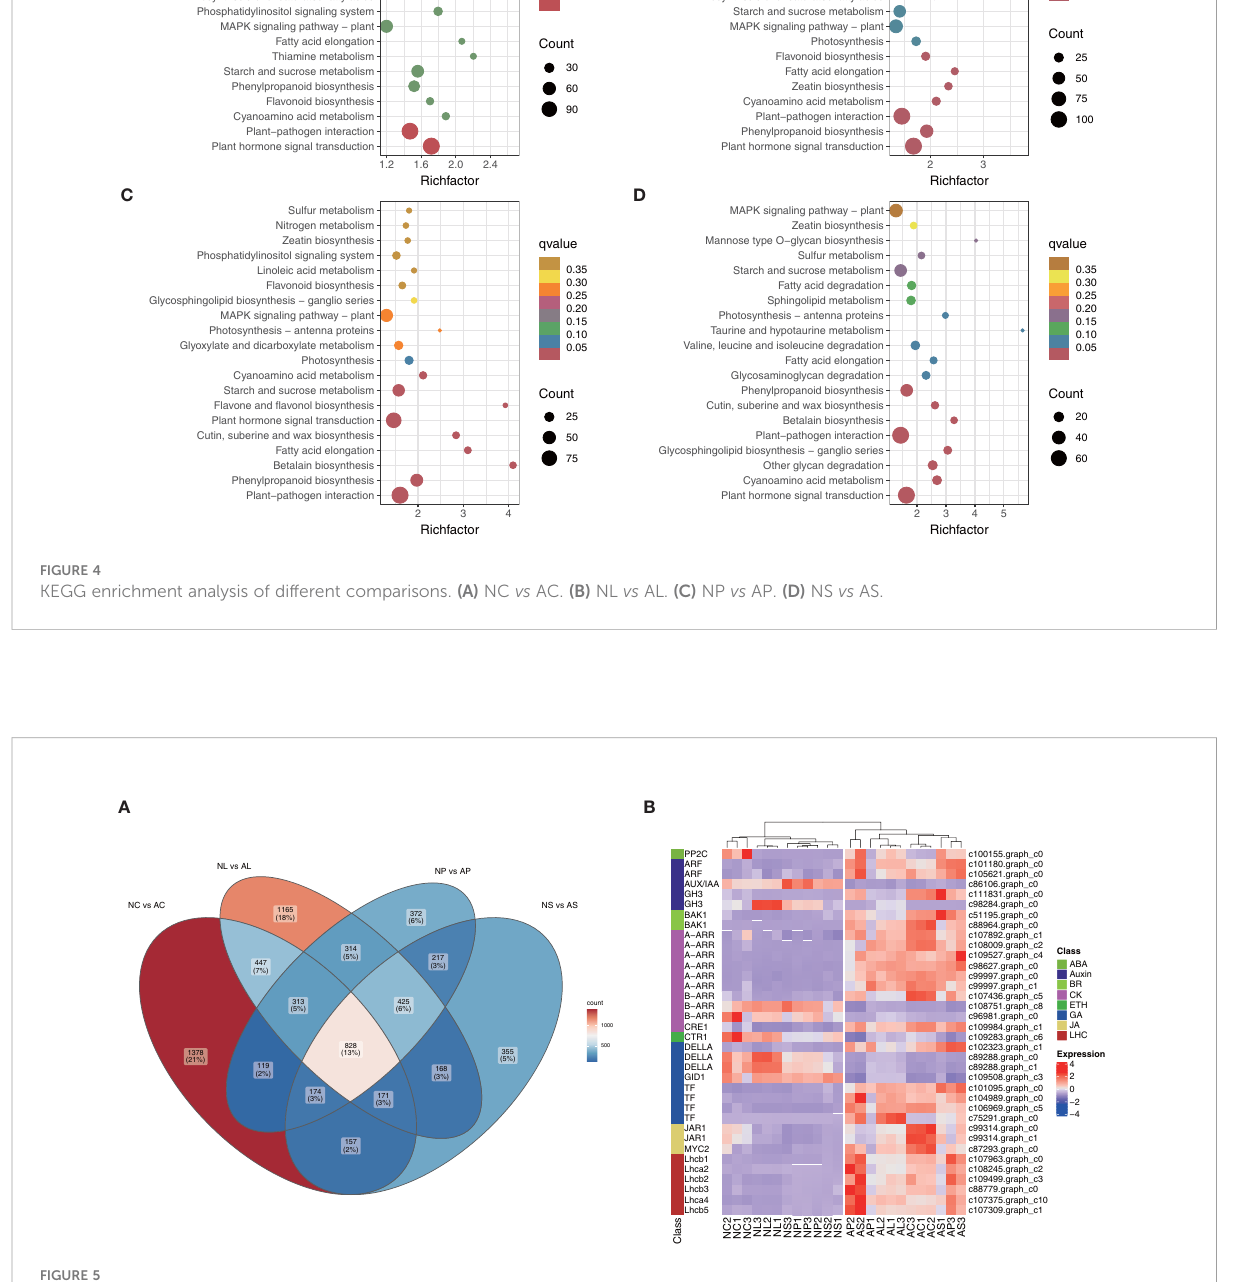
FIGURE 5 Screening of key genes. (A) Venn diagram for the four comparisons. (B) Annotation of key genes involved in plant hormone signal transduction and of all genes involved in the photosynthesis-antenna protein pathways shown in the heatmap, scaled by rows. LHC, light-harvesting chlorophyll protein complex.